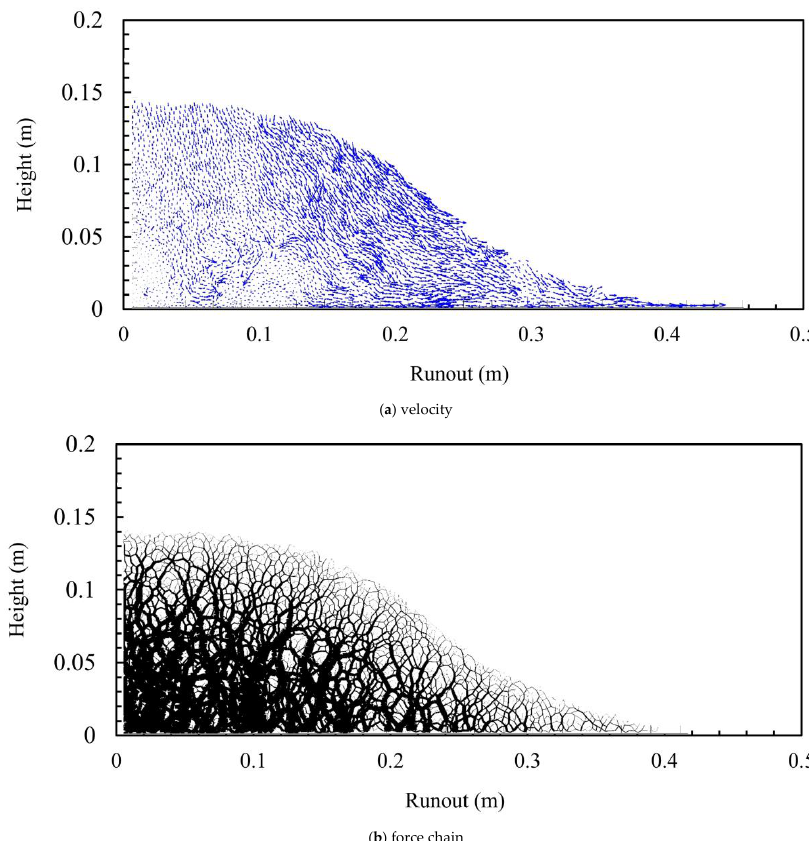
Figure 14. Velocity and force chain profiles at 50